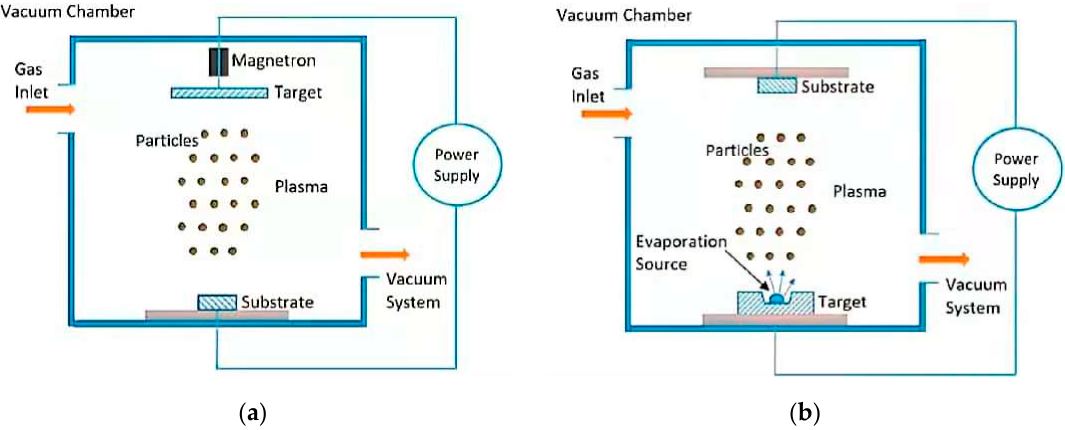
Figure 2. Schematic diagram of physical vapor deposition (PVD) sputtering and evaporation coating methods: ( a ) the sputtering; ( b ) the evaporation